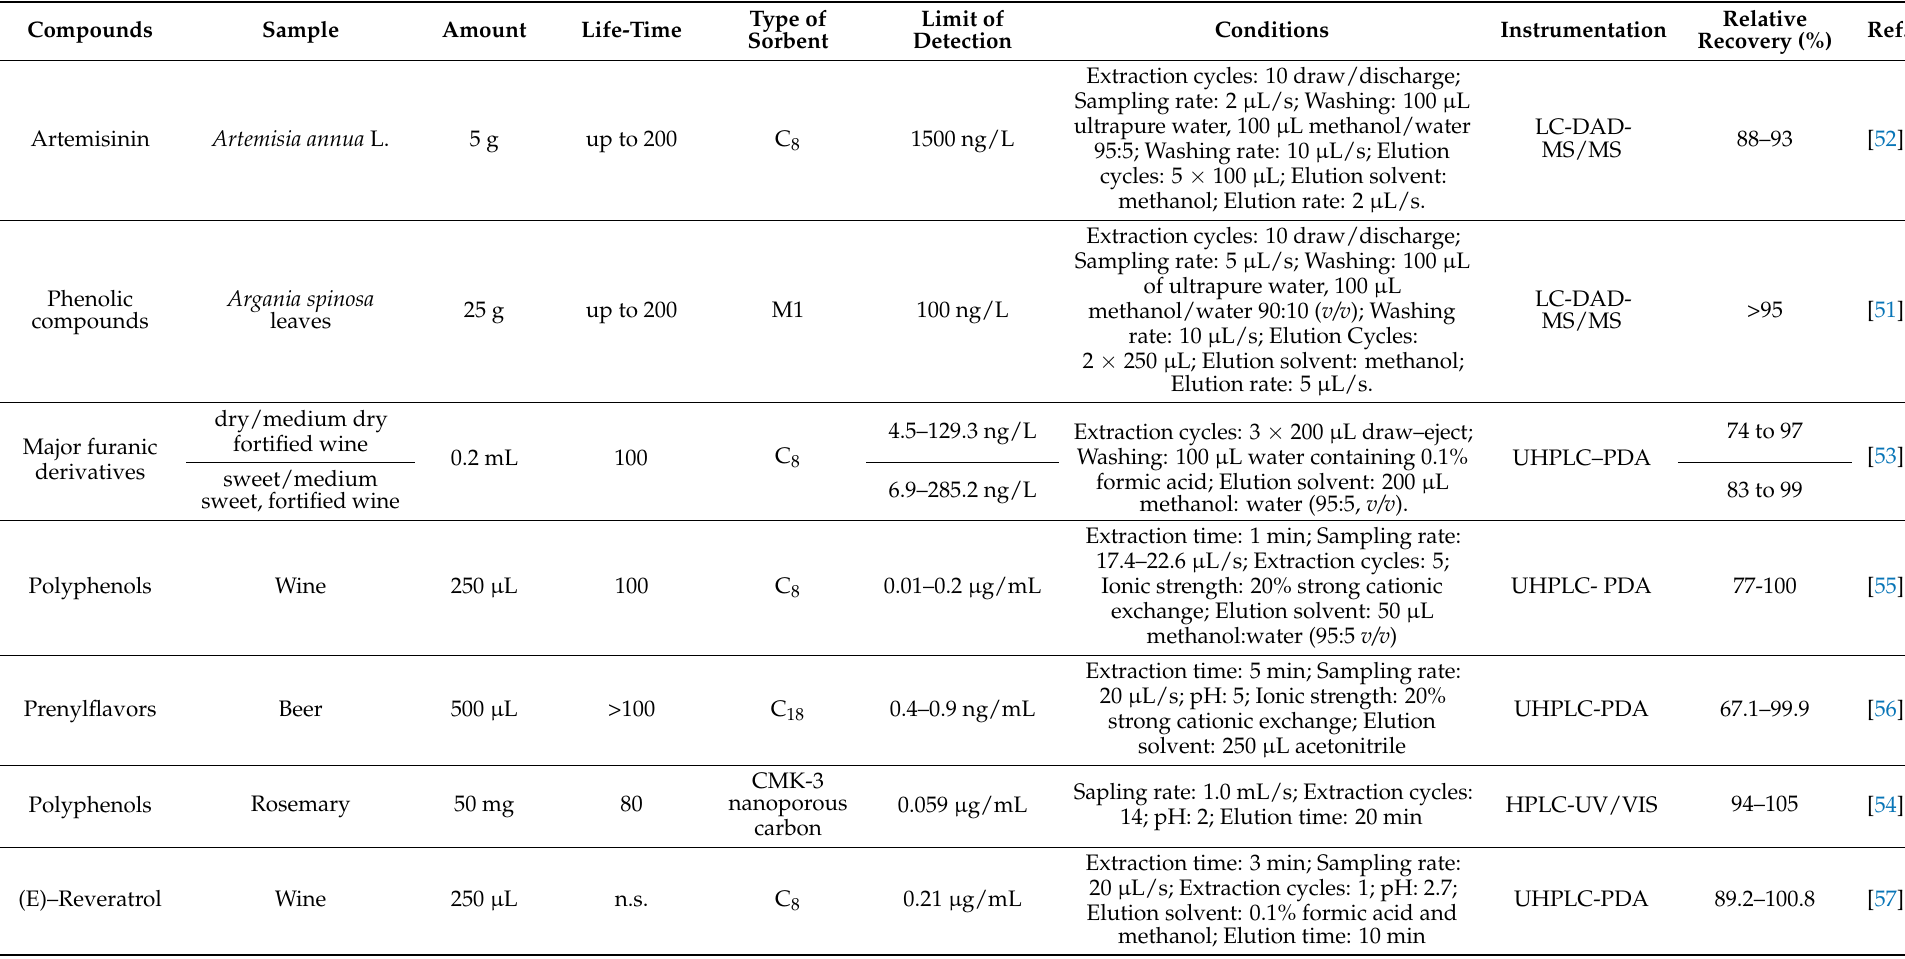
Table 2. Application of MEPS techniques for extraction of several compounds in natural